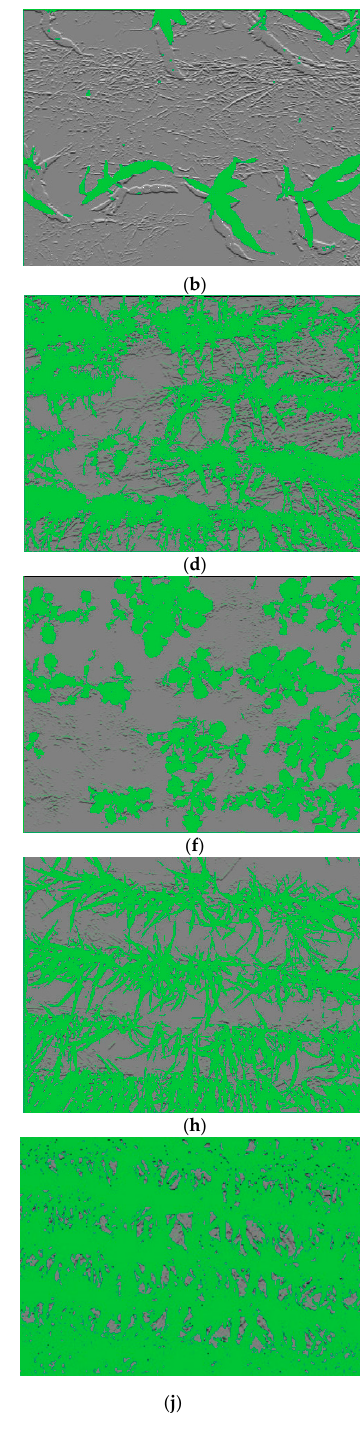
Figure 4. ( a – j ) Image segmentation using ACE. Photographs taken with a handheld digital camera along with the respective segmentations performed by ACE. Corn ( a , b ); flax ( c , d ); rapeseed ( e , f ) and oat ( g , h ). Remotely sensed corn, taken from a platform 7 m above the soil surface ( i ); and its ACE segmentation ( j